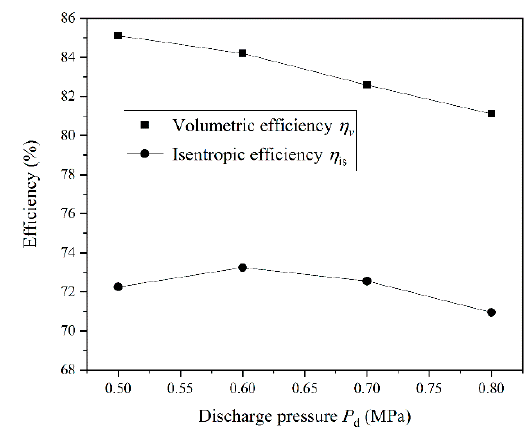
ffi ciencies under di ff erent discharge Figure 15. The compressor efficiencies under different discharge pressures. Figure 15. The compressor e